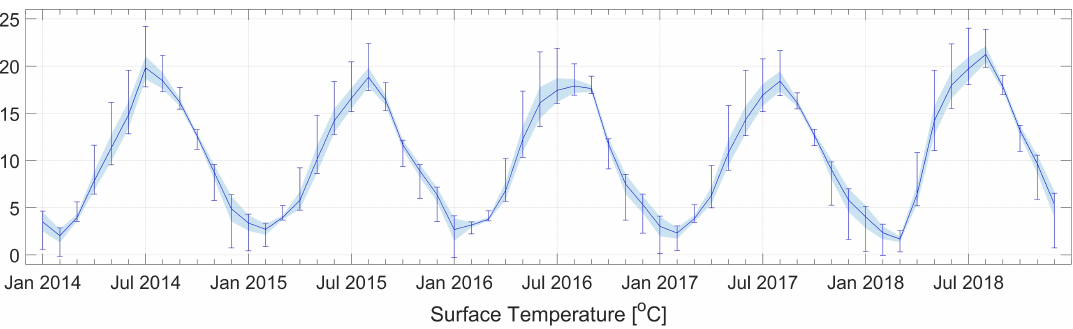
Figure 7. Monthly means of temperature at sea surface level for whole domain. Error bars represent minimum and maximum values. Solid line connects monthly means and shadow area shows standard deviation from the mean values.